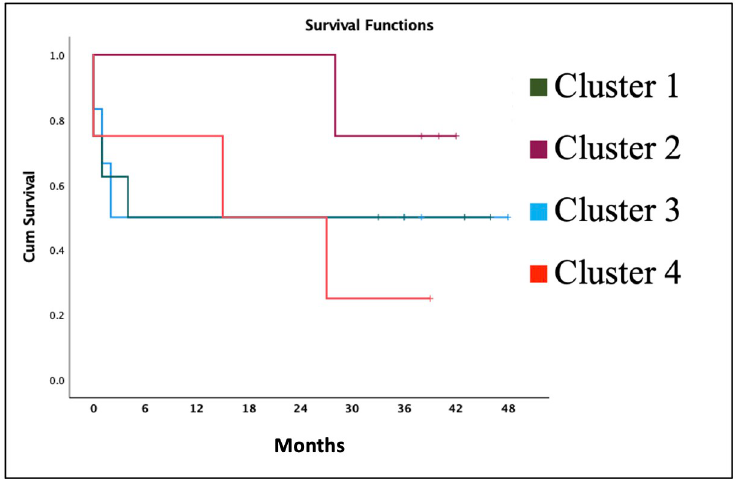
Fig 2. Survival rate based on co-occurring